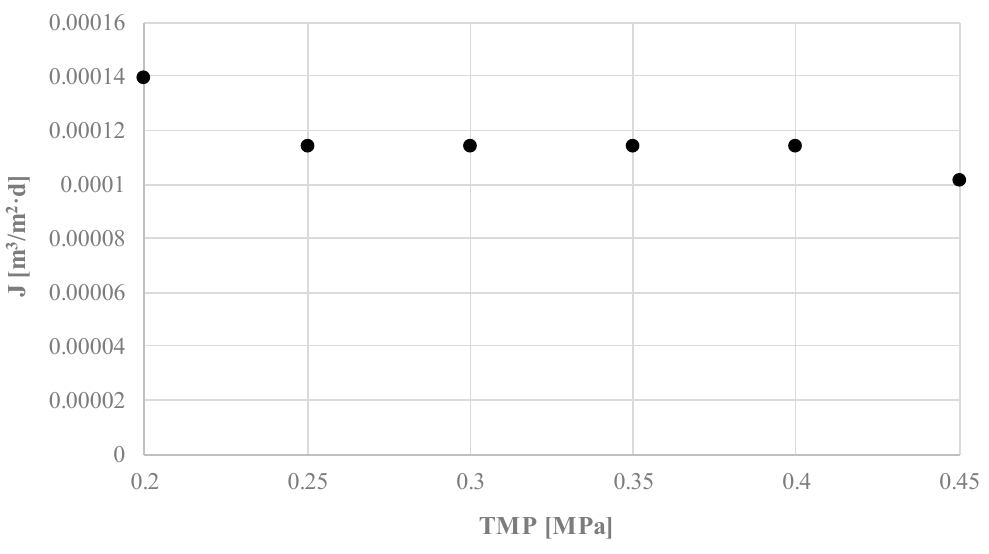
Figure 4. The influence of transmembrane pressure on permeate volume flux of ultrafiltered liquid fraction of the digestate.